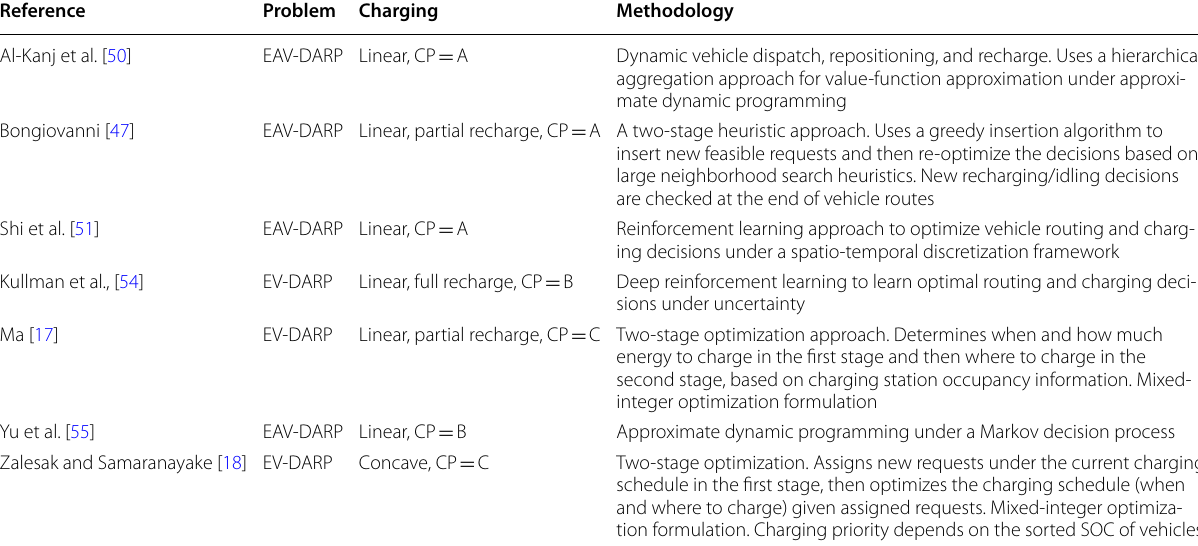
Table 2 Summary of the dynamic EV‑DRT literature